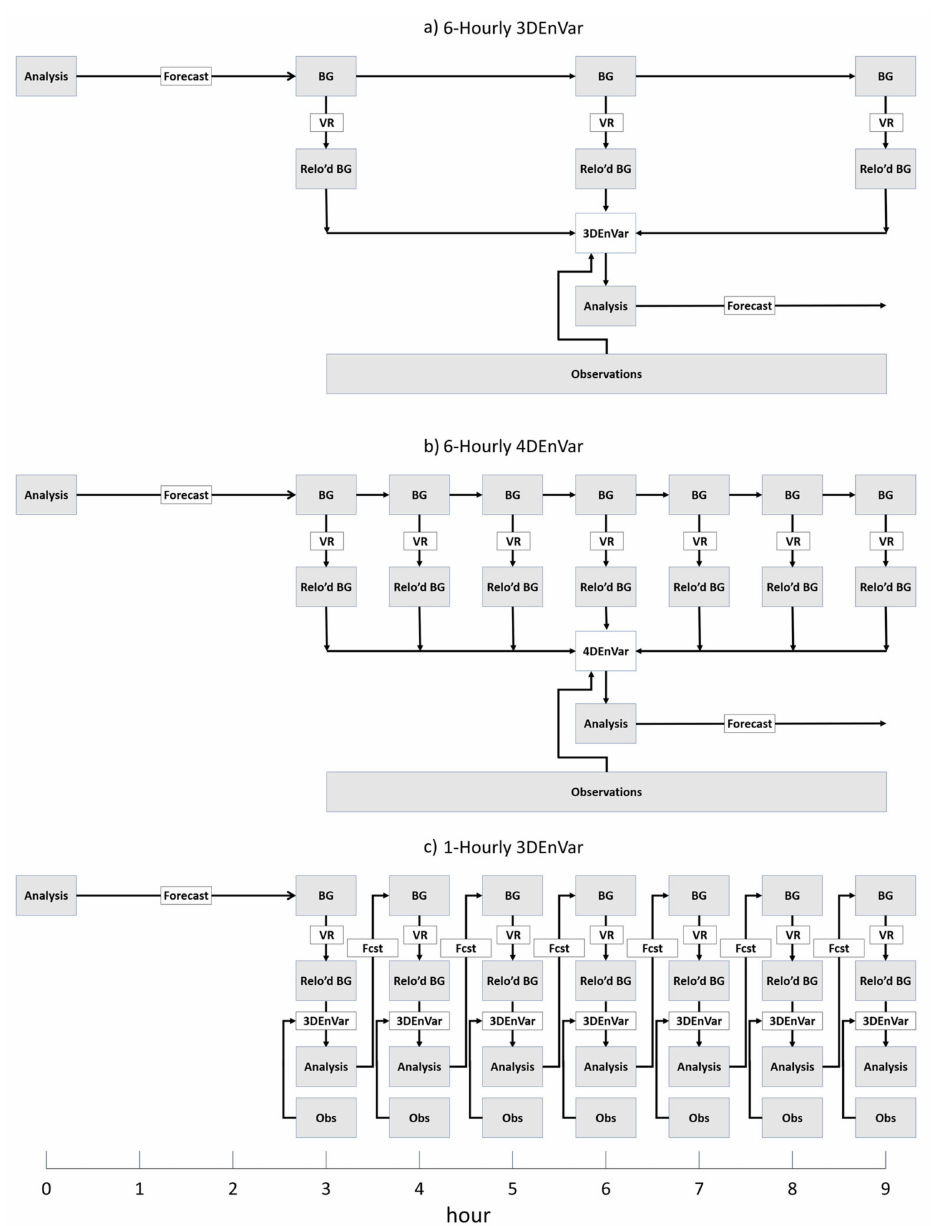
Figure 2. Comparison of the ( a ) six-hourly 3DEnVar, ( b ) six-hourly 4DEnVar, and ( c ) one-hourly 3DEnVar